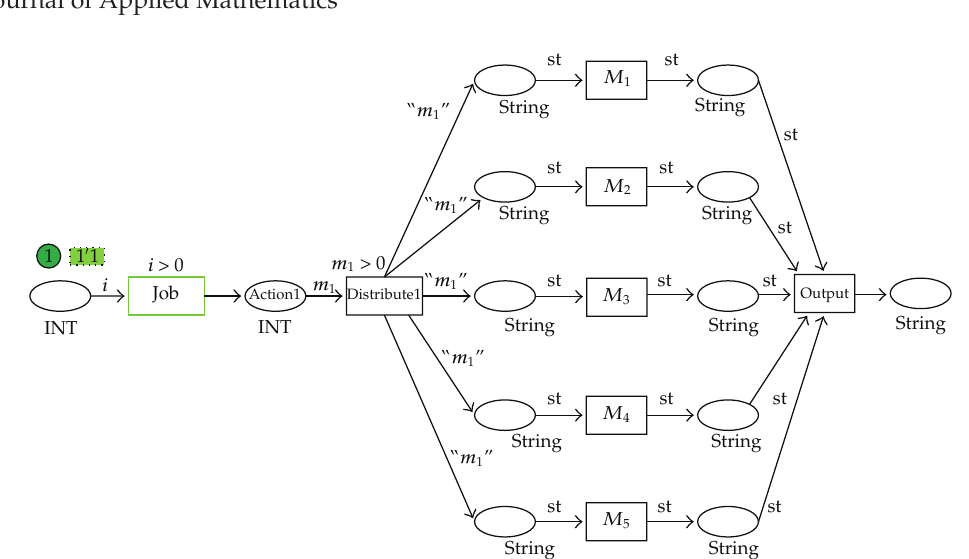
Figure 3: Example model for one job with one operation on five